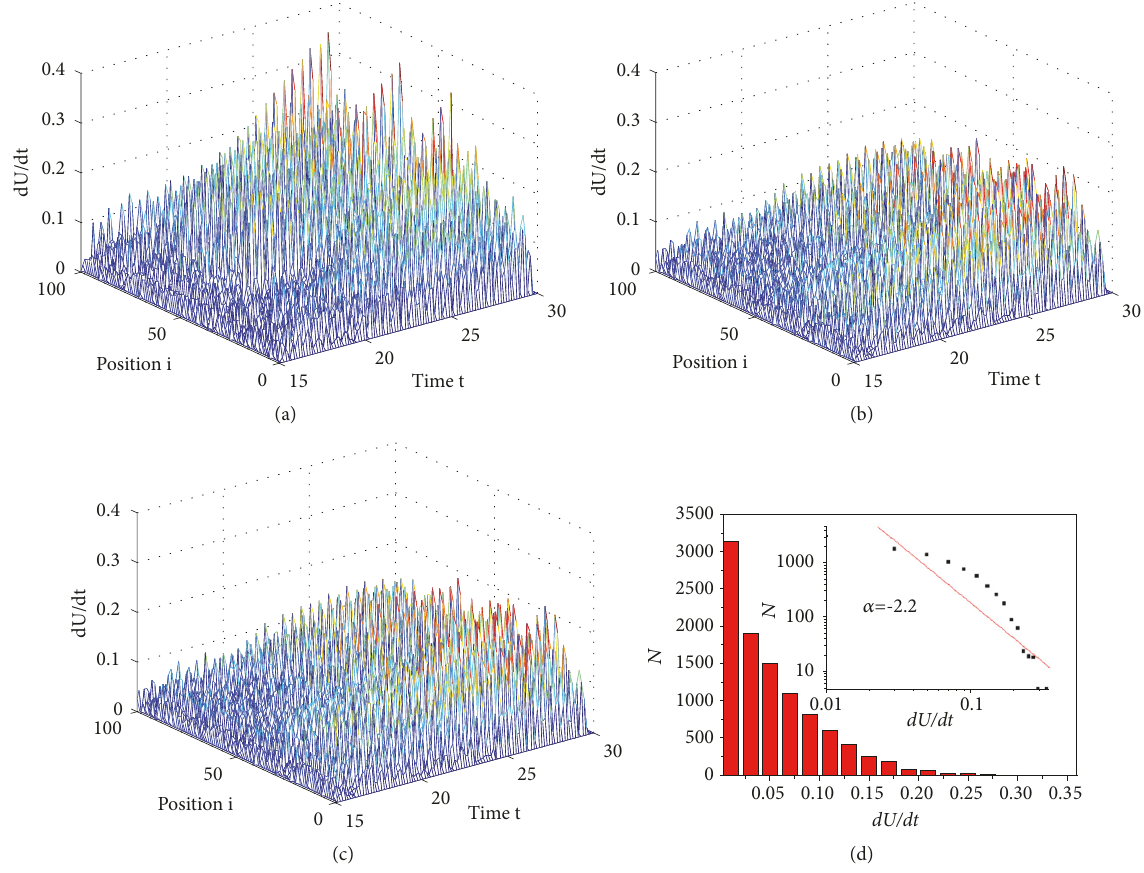
Figure 12: Various sizes of events at (a) 𝜀 = 0.65, 𝑘 0 = 1.8 × 10 16 , (b) 𝜀 = 0.15, 𝑘 0 = 1.8 × 10 16 , and (c) 𝜀 = 0.65, 𝑘 0 = 0.8 × 10 16 and (d) the distribution 𝑁 versus the sliding speed, 𝑑𝑈/𝑑𝑡 , of each block at 𝜀 = 0.65, 𝑘 0 = 1.8 × 10 16 , where 𝑁() represents the number of blocks with sliding speed, 𝑑𝑈/𝑑𝑡 . The parameters used here are 𝑎 = 0.007, 𝑏 = 0.007, 𝑉 𝑝𝑙 = 0.045, 𝑘 𝑐 = 4.94 × 10 16 , 𝐿 = 0.018, 𝐹 = 1.43 × 10 18 , 𝑀 = 1.0 × 10 17